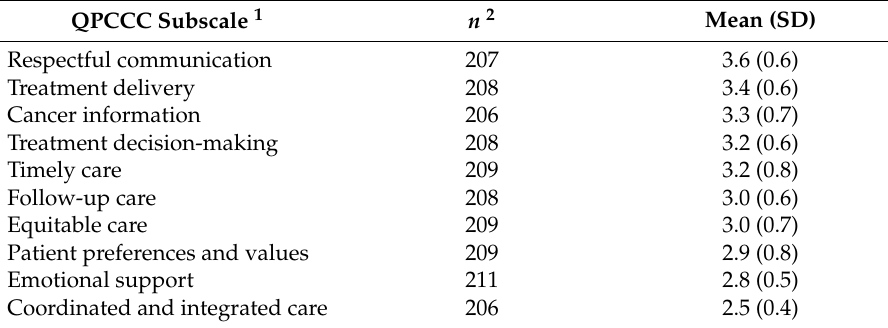
Table 5. QPCCC subscale